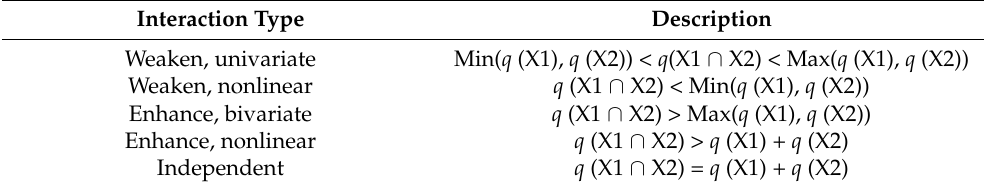
Table 2. Types of interaction relationships between the two